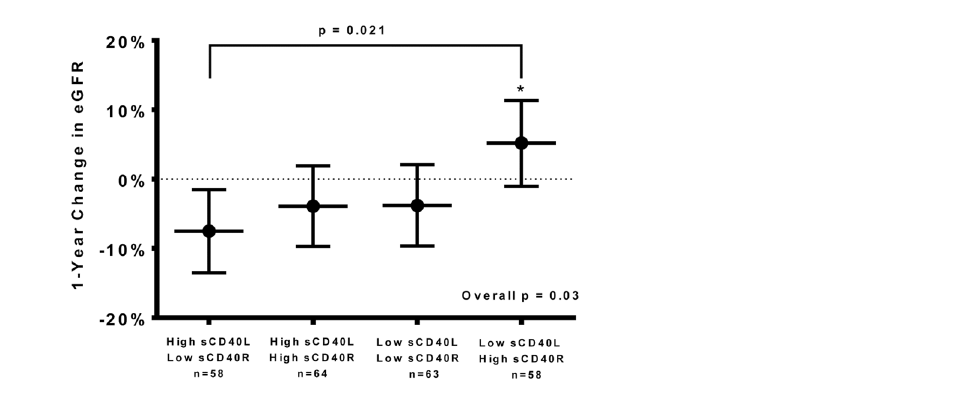
Figure 2. Comparison of 1-year percent change in eGFR between the combined sCD40L and sCD40R groups. Subjects were stratified into four groups based on median plasma levels of sCD40L and sCD40R. Data is presented as the mean ± 95% confidence